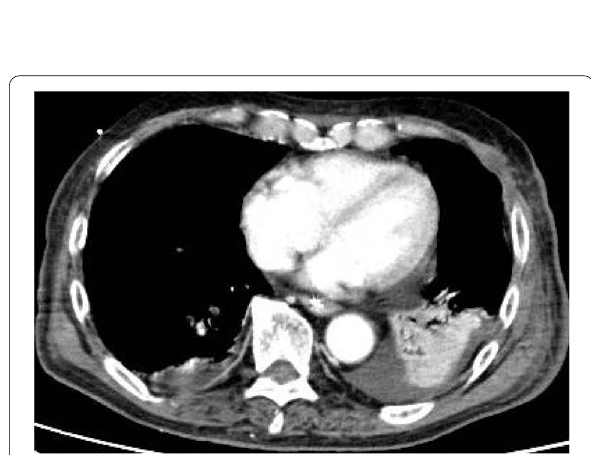
Fig. 2 Chest computed tomography scans showing atelectasis in the left lower lung field on day 9, before intrapulmonary percussive ventilation